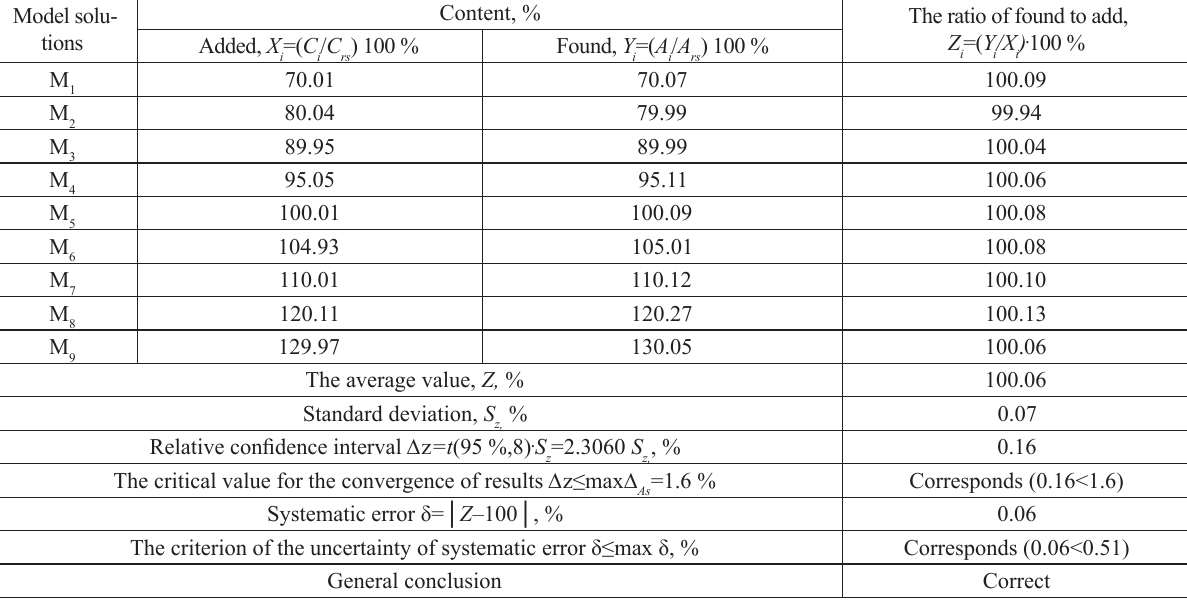
The results of the analysis of model mixtures and their statistical processing for the quantitative determination Model